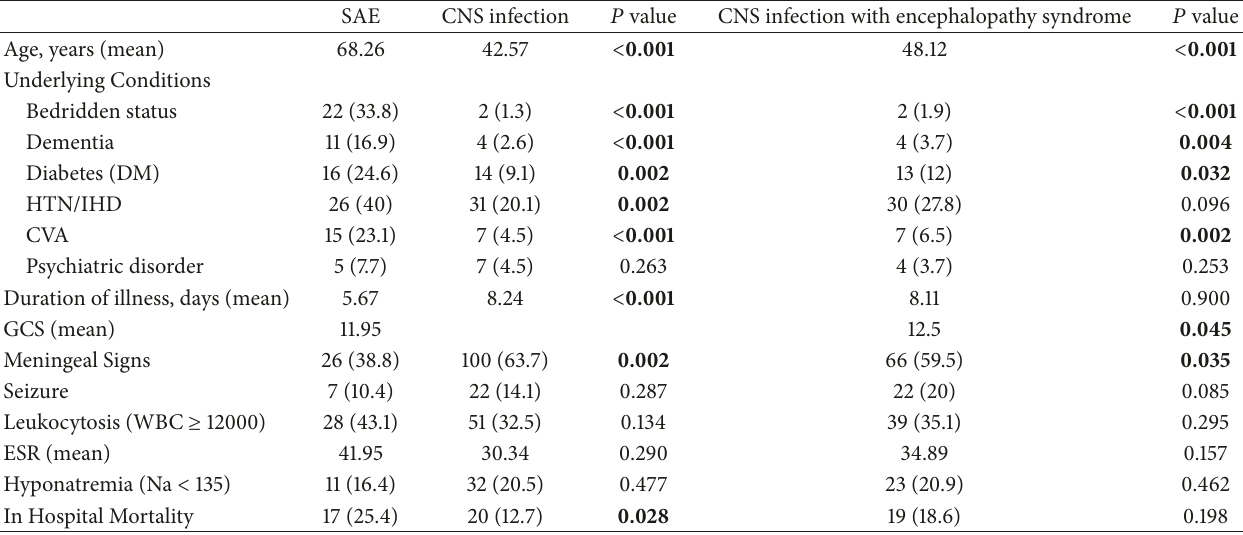
Table 2: The comparison of the characteristics between patients with CNS infection and